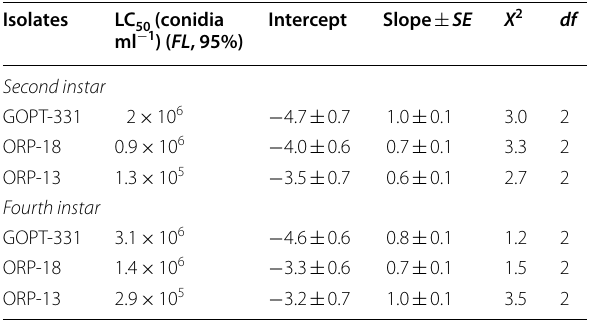
Table 5 The LC values for different fungal isolates applied to 50 the second and fourth larval instars of Thaumetopoea